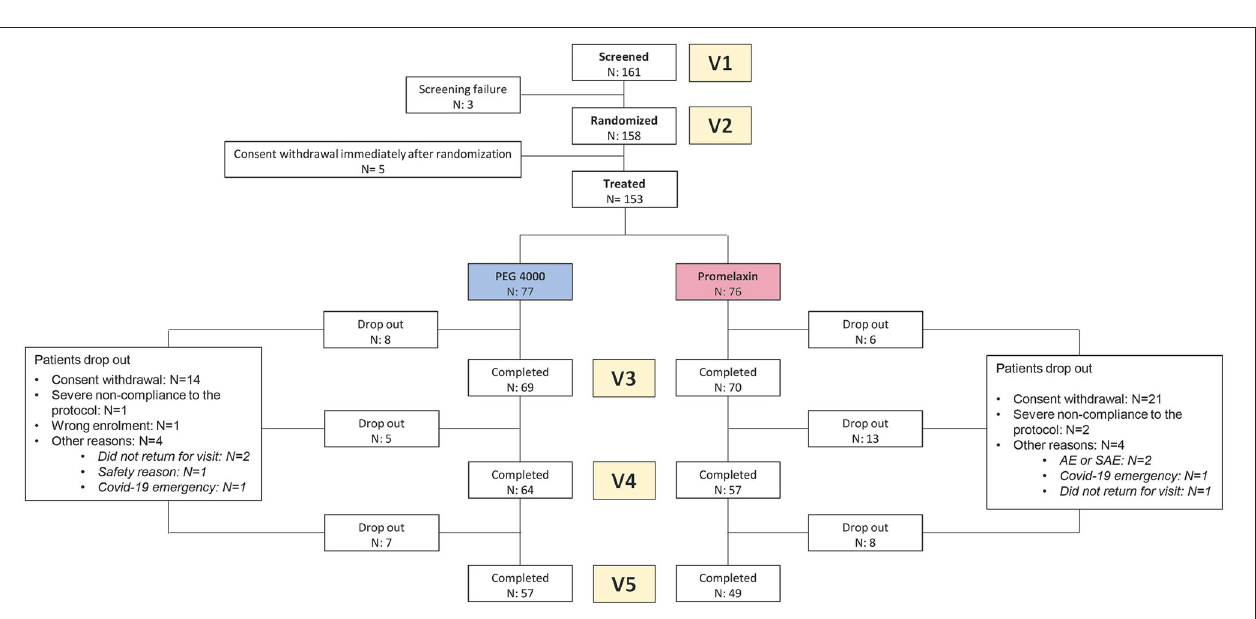
Frontiers in Pediatrics |